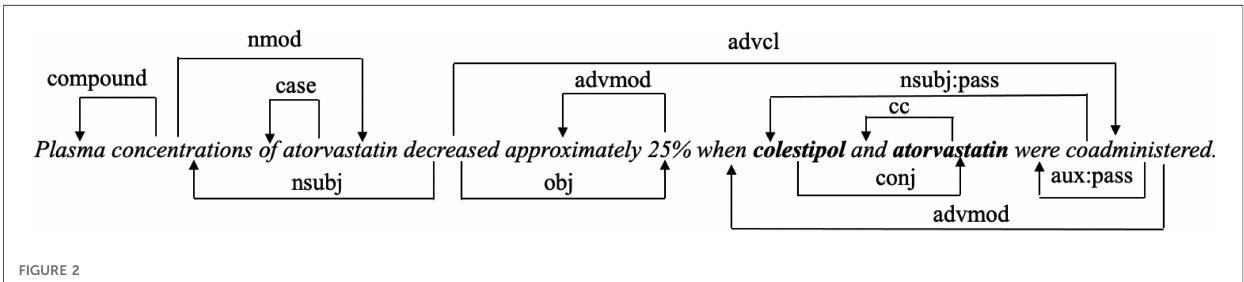
FIGURE 2 An example of dependency relation. Two drugs are labelled in